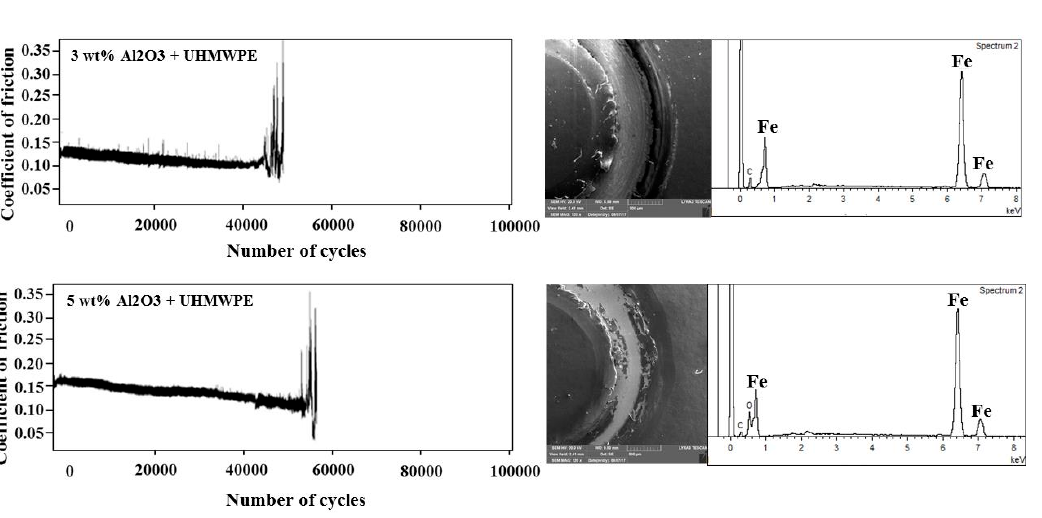
Figure 11. Typical frictional graphs, FESEM/EDS spectrums of the wear track after a sliding wear test of 100,000 cycles conducted on the nanocomposite coatings with different loadings 3 and 5 wt % of alumina, respectively, at a normal load of 15 N and at a sliding speed of 0.1 m/s.